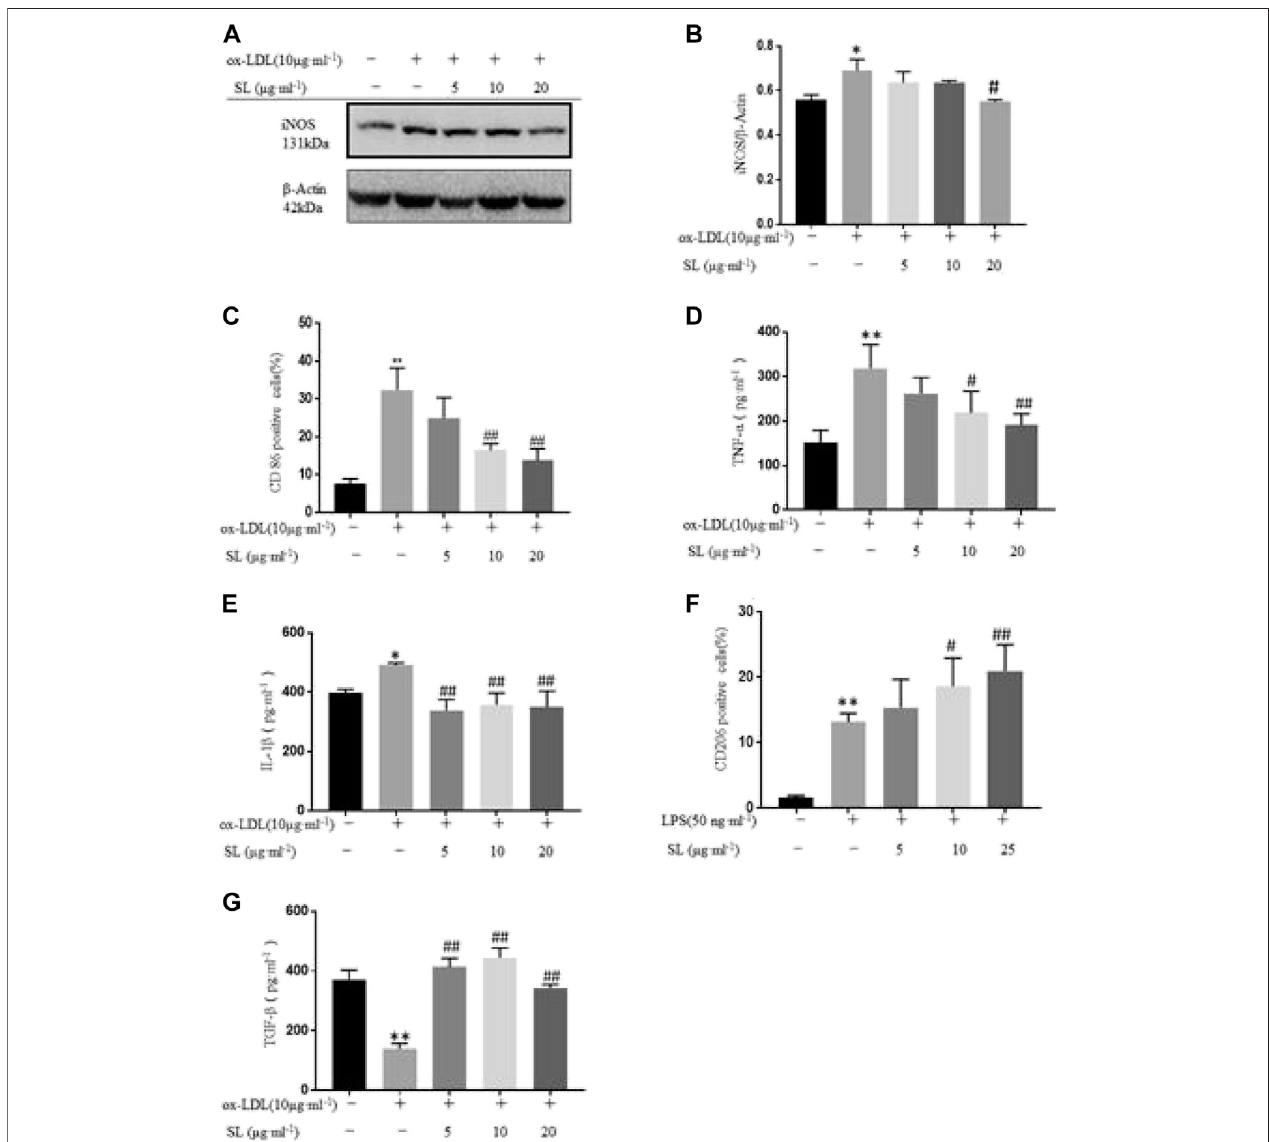
FIGURE 1 | SL extract regulated transformation of macrophage phenotype in an in flfl ammatory injury model. (A, B) Western blotting veri fifi cation of M1 macrophage polarization related marker iNOS in cells treated with SL (from 5 to 20 μ g ml-1) for 24 h in RAW264.7 cells in the absence or presence of ox-LDL, n (cid:2) 3. (C) EffectofSLontheexpressionofM1markerCD86inRAW264.7by flfl owcytometry.n (cid:2) 4 (D,E) DetectionofM1macrophagepolarizationrelatedmarkers(TNF- α andIL- 1 β ) byELISAinsupernatantofRAW264.7 cells treatedwith SL24h, n (cid:2) 3. (F) Effect ofSL onexpression oftheM2 marker CD206inRAW264.7by flfl ow cytometry in the absence or presence of LPS (50 ng ml-1), n (cid:2) 6. (G) Detection of M2 macrophage polarization related marker (TGF- β ) by ELISA in supernatant of RAW264.7 cells treatedwithSL24h, n (cid:2) 3.* p < 0.05and ** p < 0.01 compared tountreated group, and # p < 0.05and ## p < 0.01compared tocontrolgroupstreated withmodelgroup. kit (Beyotime, China). The same amounts of denatured protein gel electrophoresis (SDS-PAGE) and the gels were electrically blotted onto a PVDF membrane (Millipore, United States).